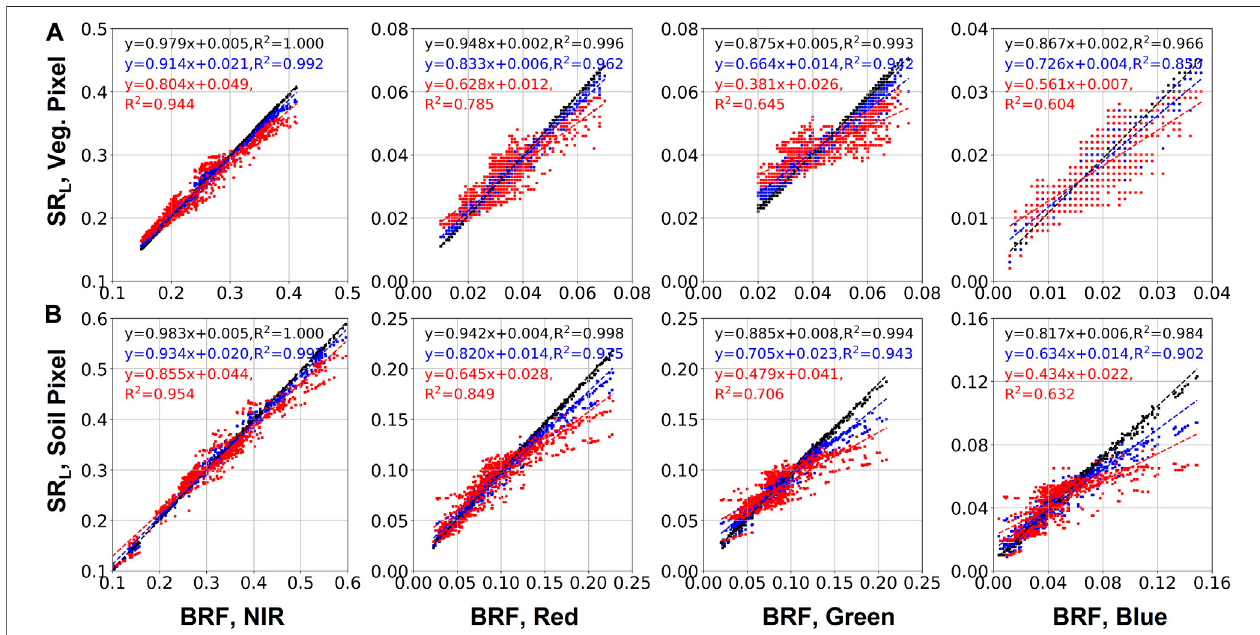
FIGURE8| Simulated scatterplotsofLambertian SRvsaccurateBRFforrandomlyselectedvegetated greenpixel (A) andbrownsoilpixel (B) intileH11V05 inthe vis-NIR bands. The Lambertian SR was computed from the simulated TOA re fl ectance for all MODIS observations in 2018 using MAIAC BRDF model. The simulations were performed for different levels of atmospheric opacity, including very clear (AOD 0.47 (cid:1) 0.05, black), moderately hazy (AOD 0.47 (cid:1) 0.5, blue) and hazy (AOD 0.47 (cid:1) 1.5, red) conditions.